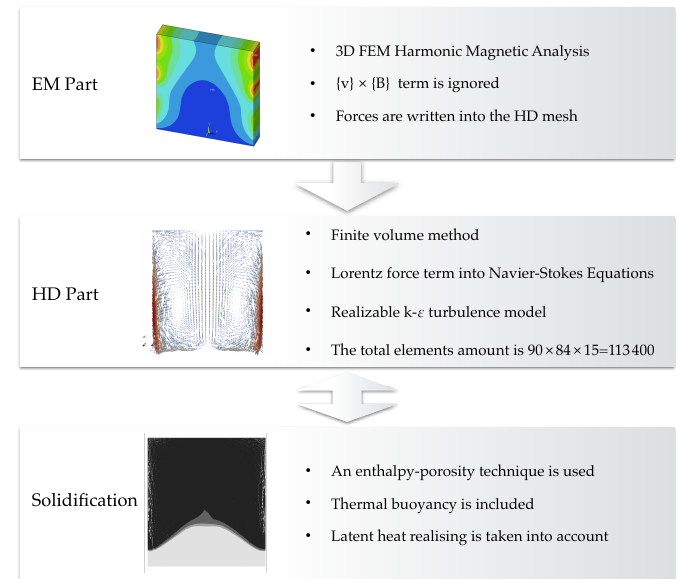
Figure 2. Numerical scheme for the solidification process in presence of travelling magnetic field (TMF).